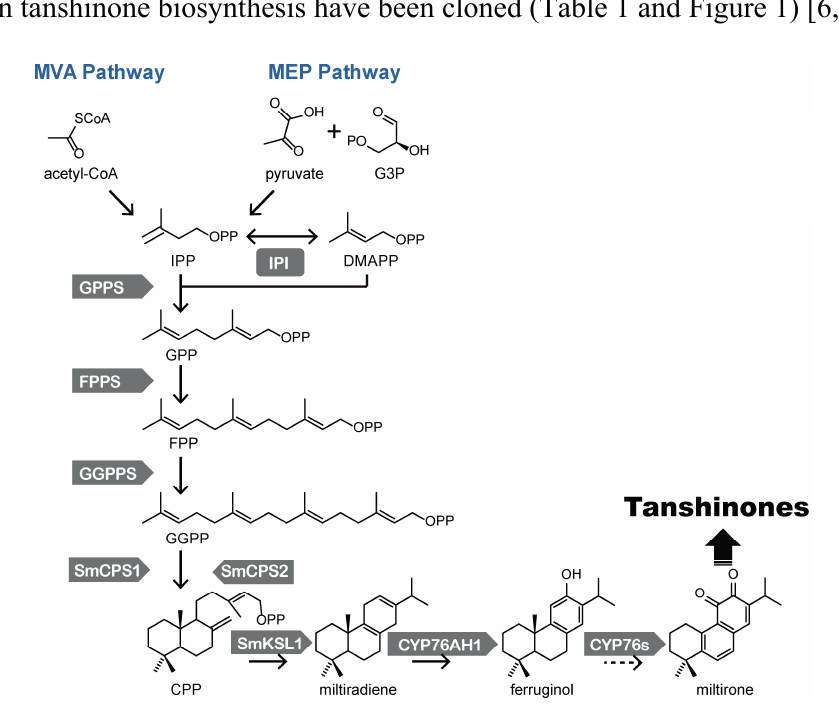
Figure 1. Biosynthethsis of tanshinones in S. miltiorrhiza . Solid arrows indicate the established relationships, and dashed arrows indicate hypothetical relationships. G3P: glyceraldehyde-3-phosphate, IPP: isopentenyl pyrophosphate, DMAPP: dimethylallyl pyrophosphate, IPI: IPP isomerase, GPP: geranyl diphosphate, GPPS: GPP synthase, FPP: farnesyl diphosphate, FPPS: FPP synthase, GGPP: geranylgeranyl diphosphate, GGPPS: GGPP synthase, CPP: copalyl diphosphate, SmCPS: CPP synthase, SmKSL: kaurene synthase-like